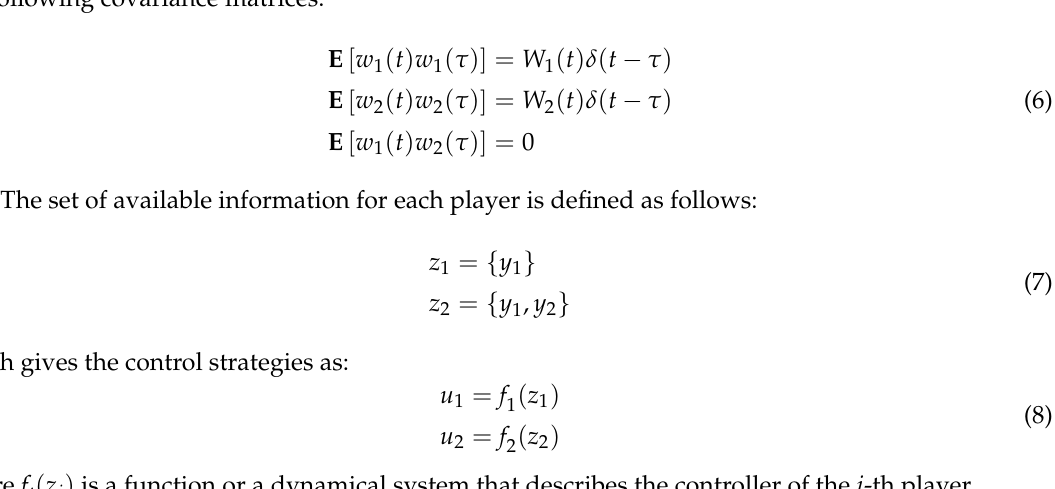
Figure 2. Two-player nested dynamical